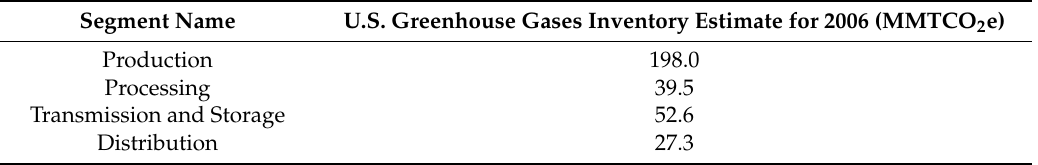
Table 5. Comparison of process emissions from each segment of the natural gas and petroleum industries in the United States